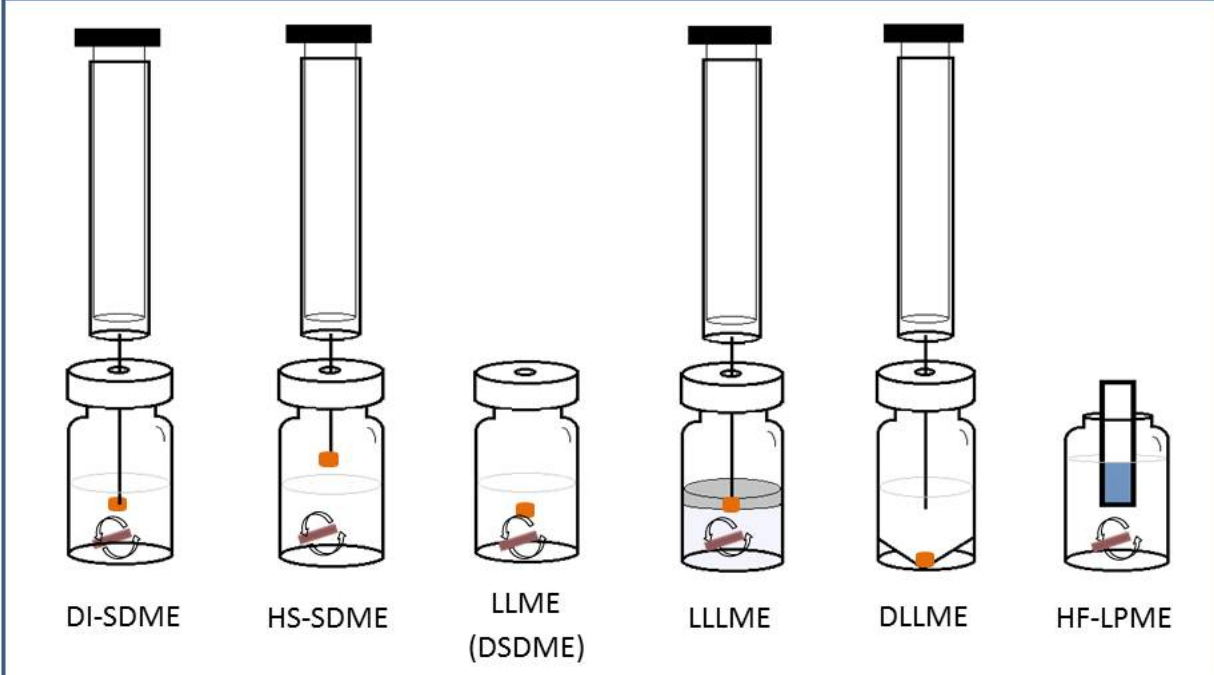
Figure 2. Scheme of some solvent microextraction